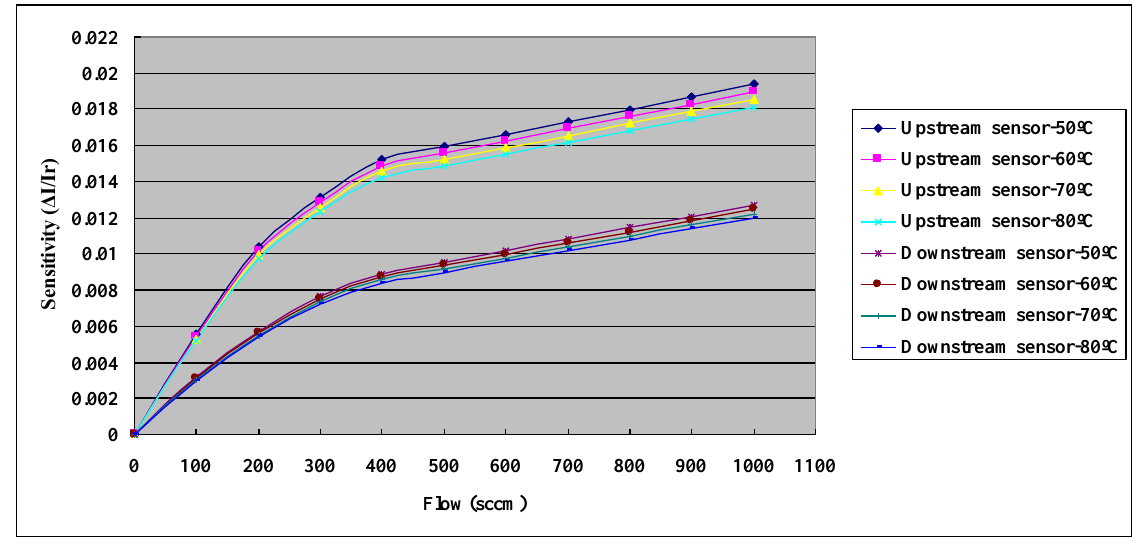
Figure 9. Calibration curves of the micro flow